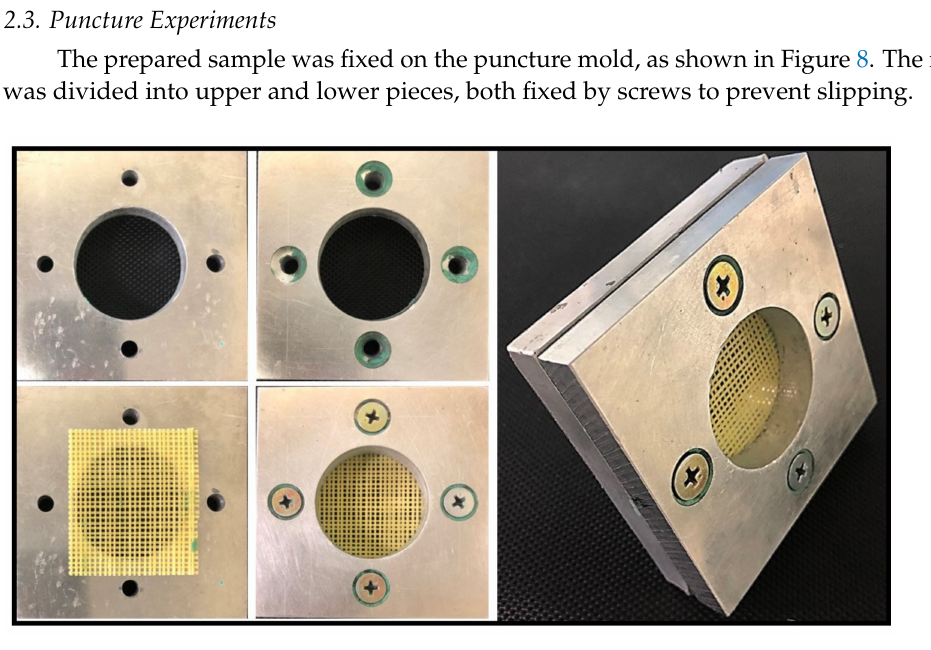
Figure 8. Preparation of the puncture sample.